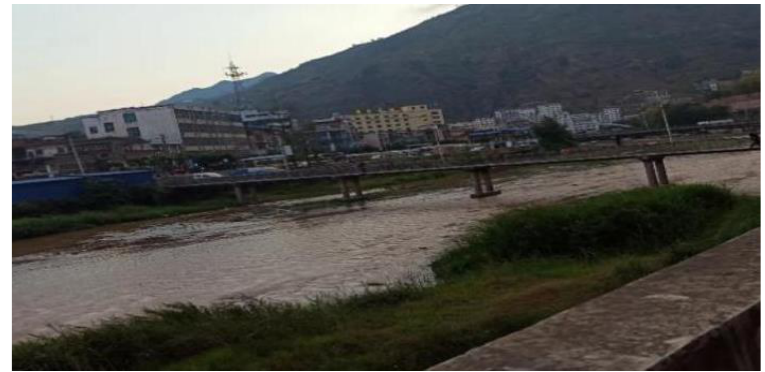
Figure 1. Mine drainage distribution map.